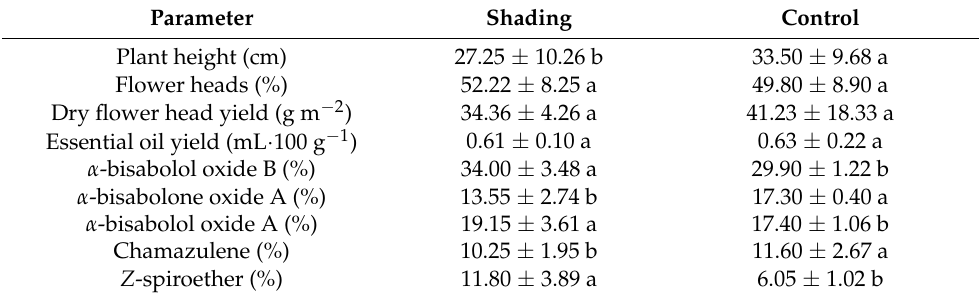
Table 3. Effects of shading (across fertilization application treatments) on growth parameters and essential oil main components (mean ± SD) of